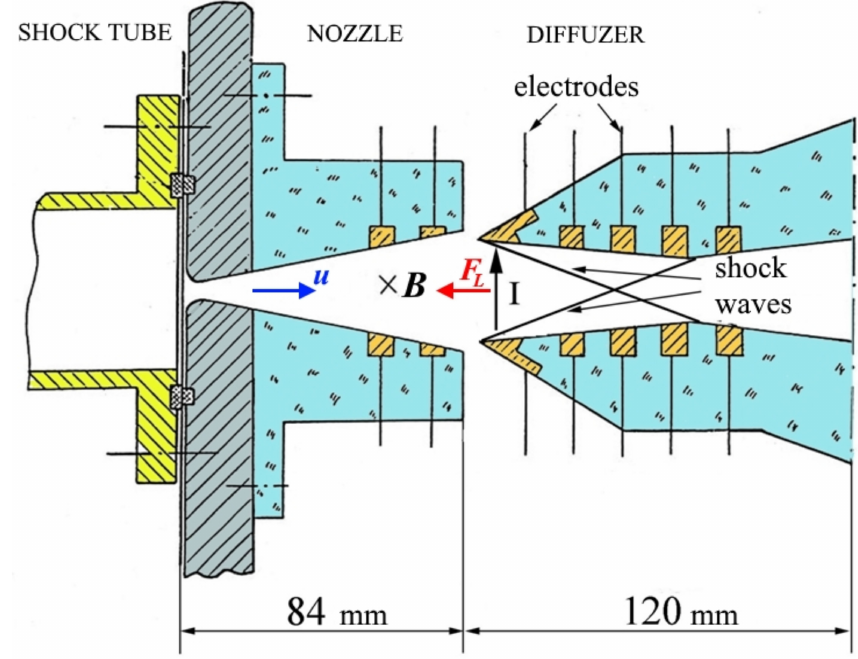
Figure 3. Scheme of the working chamber with a diffuser model.